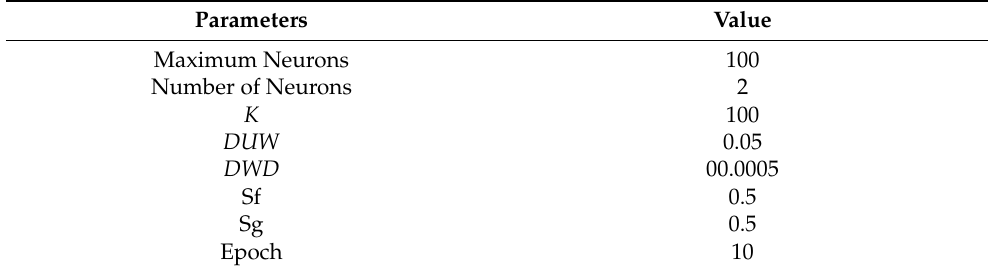
Table 2. The TASOM Parameters for the Classification of Pixels (Optimized by a Genetic Algorithm). Parameters Value Maximum Neurons